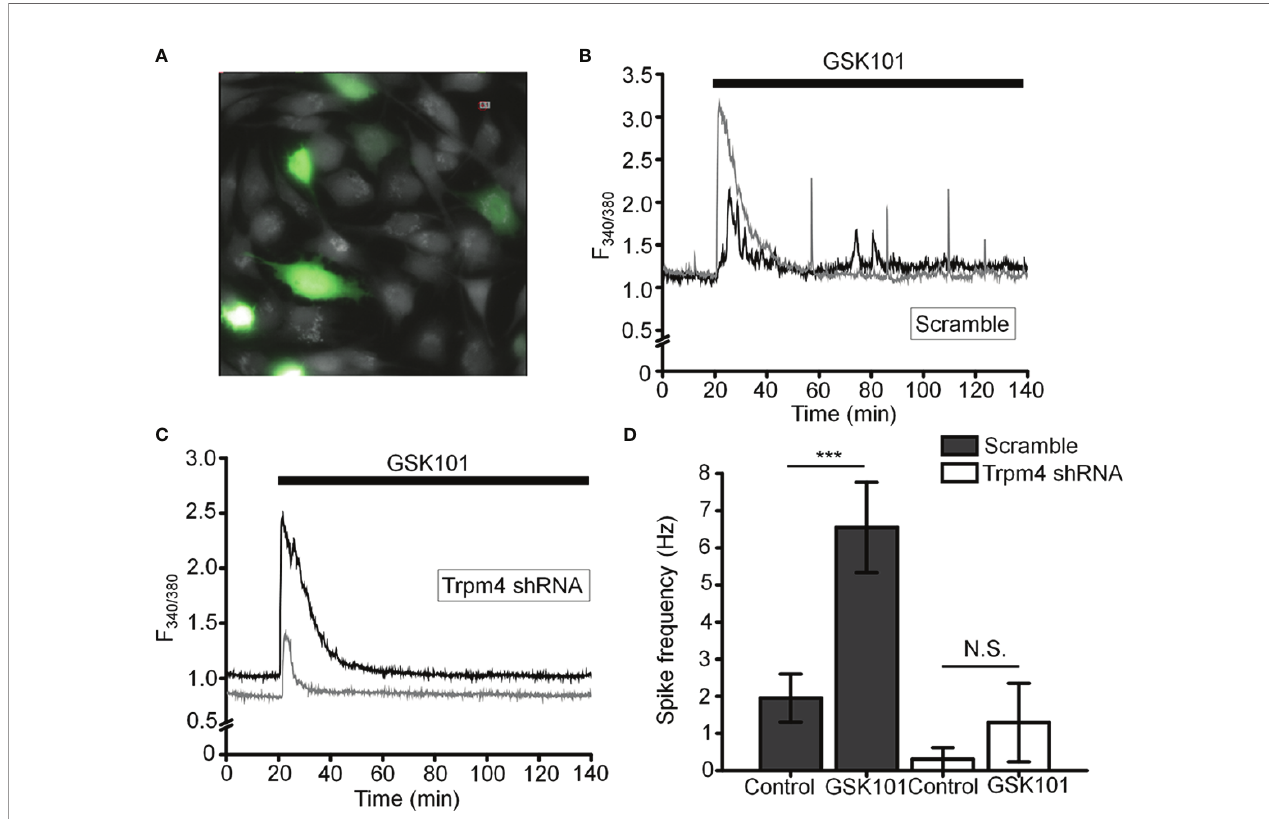
FIGURE 7 | TRPM4 knockdown disrupts GSK101-triggered [Ca 2+ ] i fl uctuations. (A) TM cells treated with Sc-GFP, and TRPM4 shRNA-GFP constructs. (B, D) Sc- shRNA-transfected cells exhibit fl uctuating [Ca 2+ ] i signals, which show (C, D) reduced frequency in TRPM4-shRNA-treated cells. Data shown as mean ± S.E.M. ***P < 0.001, N.S. P > 0.05, paired t-test, n = 116 cells and n = 27 cells for Sc- and TRPM4 shRNAs,